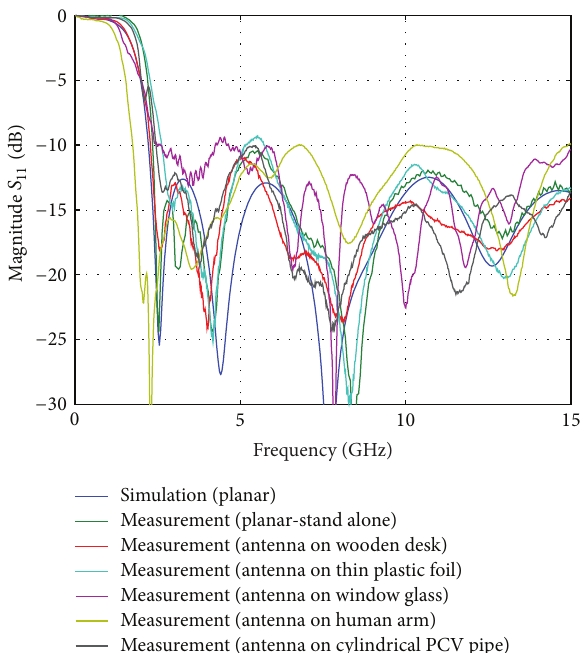
Figure 11: Magnitude of the reflection coefficient for the investigated antenna placed on different materials.